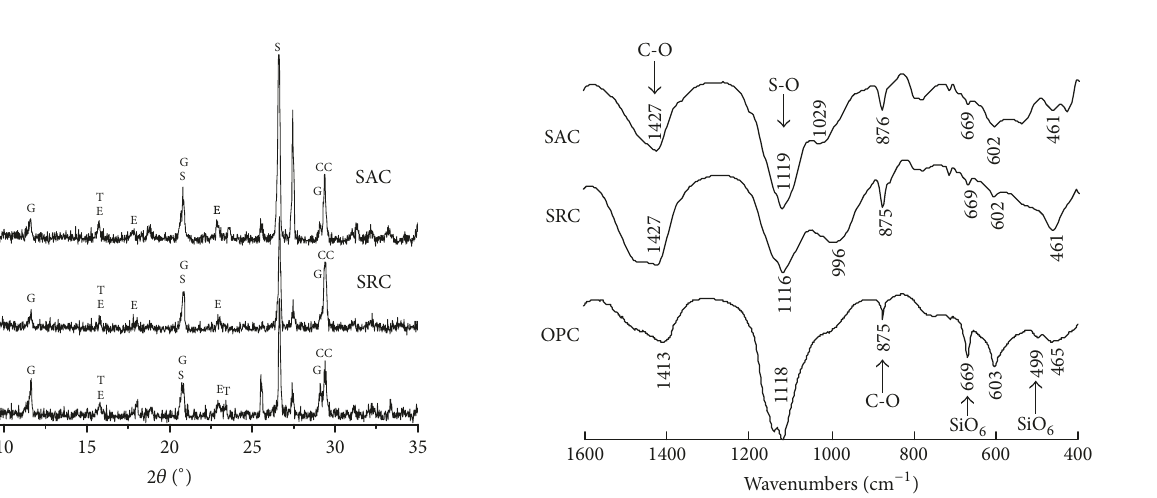
Figure 6: FTIR spectra of mortars with different types of cement after 1-year exposure to sulfate